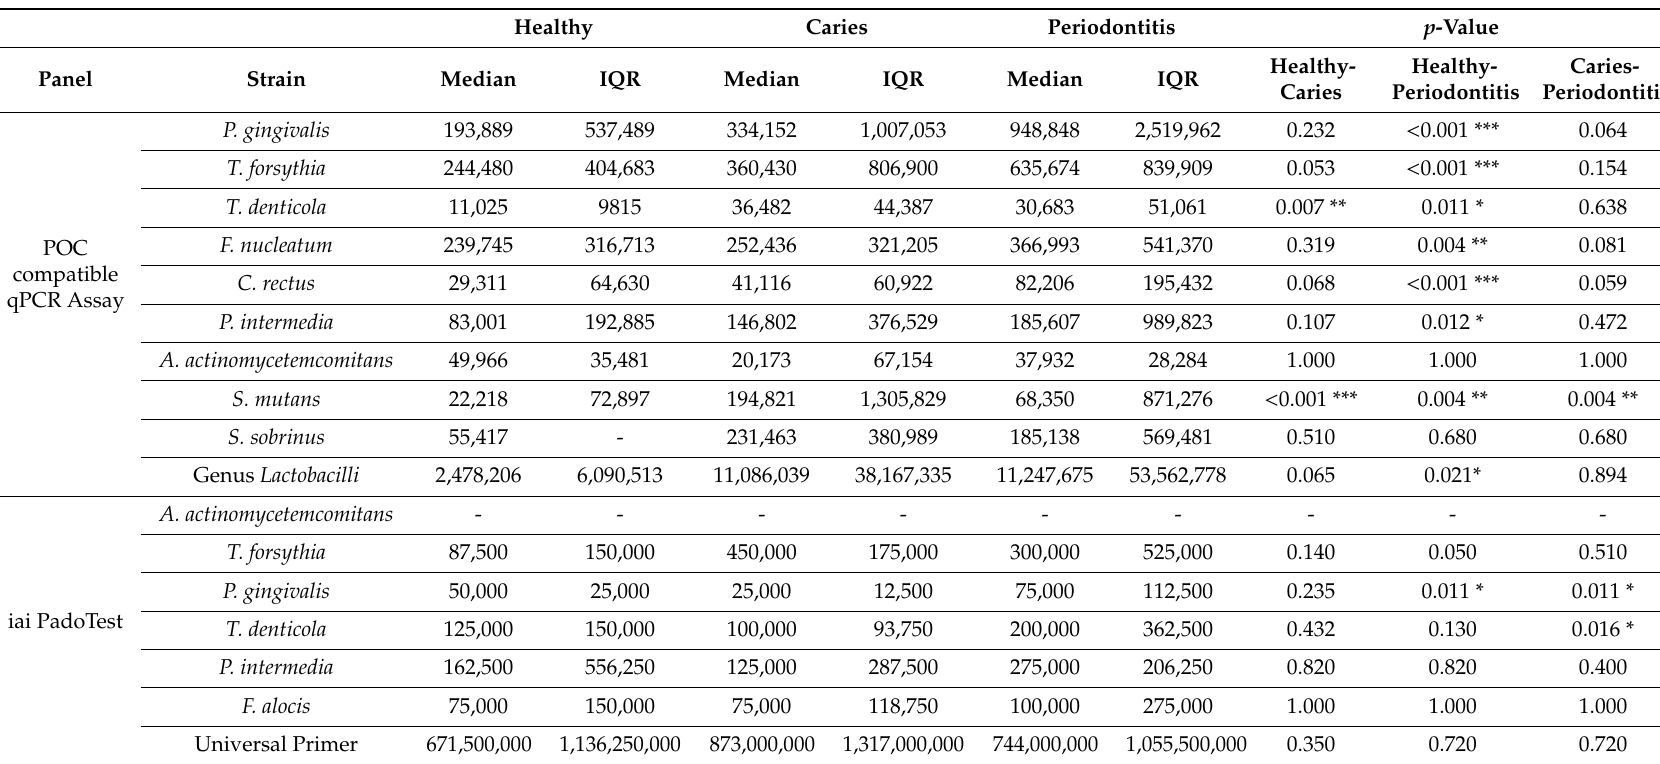
Table 2. Median values of bacterial loads (in ge / mL) and interquartile ranges (IQR) of all bacterial strains measured by the POC compatible qPCR assay and iai PadoTest, separated into groups. Statistically significant di ff erences in group comparisons (healthy versus caries, healthy versus periodontitis, caries versus periodontitis) are marked with stars; * 0.05 > p ≥ 0.01, ** 0.01 > p ≥ 0.001, *** p <